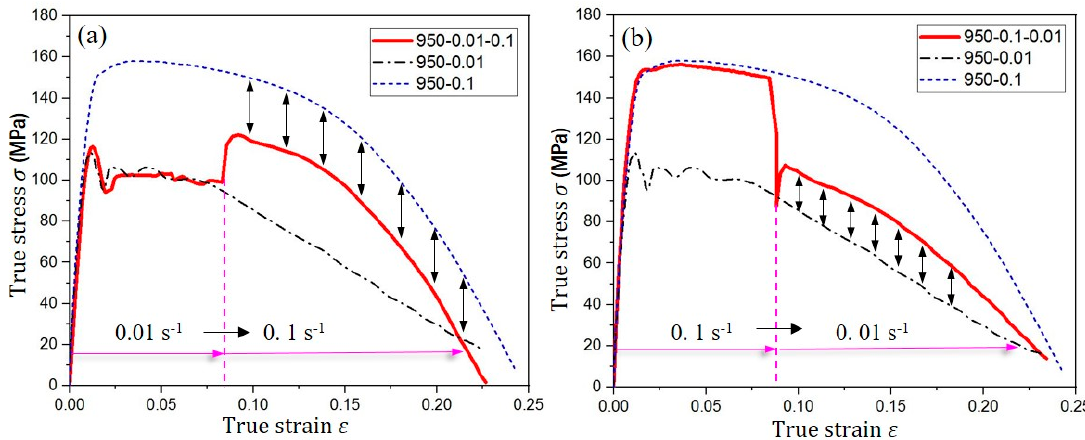
Figure 6. ( a ) The stress–strain curves with the strain rates of 0.01 and 0.1 s − 1 and changing from 0.01 to 0.1 s − 1 at 950 ◦ C, and ( b ) the stress–strain curves with the strain rates of 0.01 and 0.1 s − 1 and changing from 0.1 to 0.01 s − 1 at 950 °C.